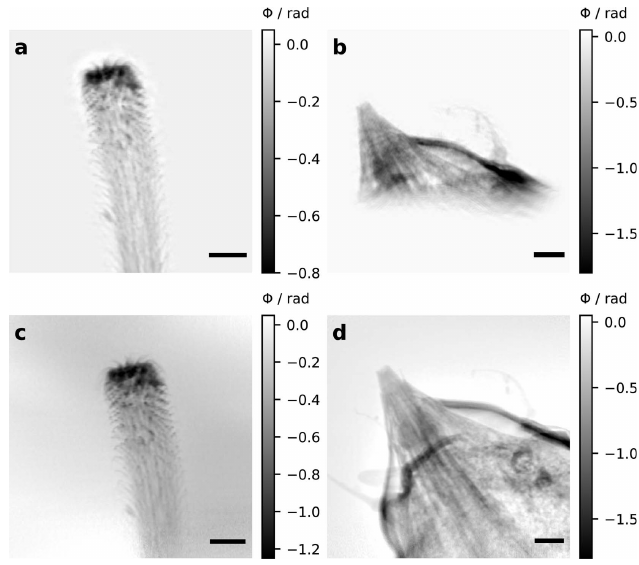
Figure 6 Phase reconstructed projections of two test samples, a spider attachment hair [( a ), ( c )] and a tardigrade head [( b ), ( d )], obtained with different phase contrast methods using a LAMBDA detector. ( a ), ( b ) Near-field holography and ( c ), ( d ) near-field ptychography. Note: ( b ) and ( d ) might not show exactly the same angle and region, since the sample was remounted between the two experiments. The scale bar indicates 5 m